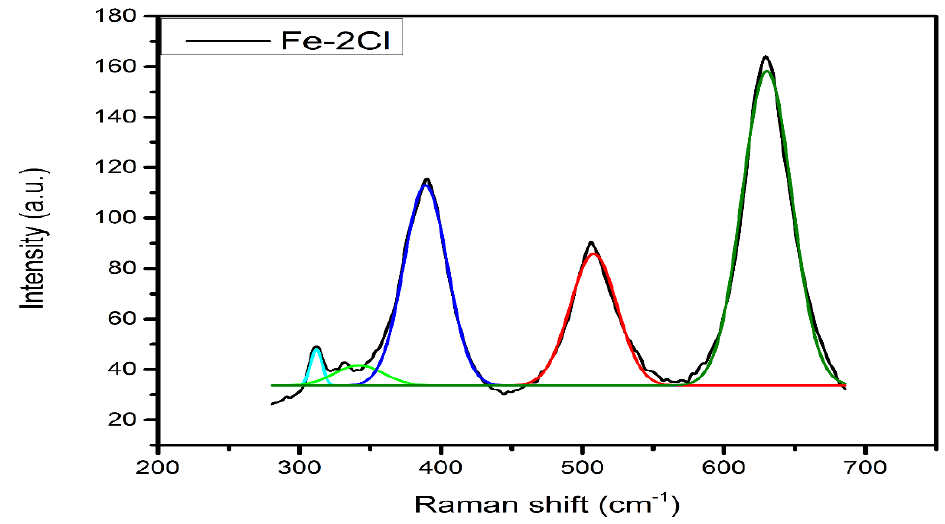
Figure 8. Deconvolutions of Raman spectra of the sulphur catalyst (FeS–2Cl). Table 3. Sulfide-Oxide ratio from Raman spectra.